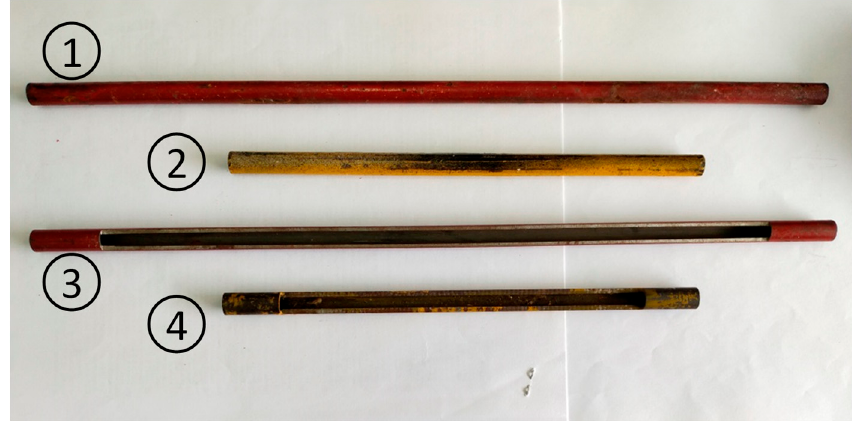
Figure 4. Intact rod (Rods 1 and 2) and damaged rod (Rods 3 and 4, with 50% cut-off of the cross section).